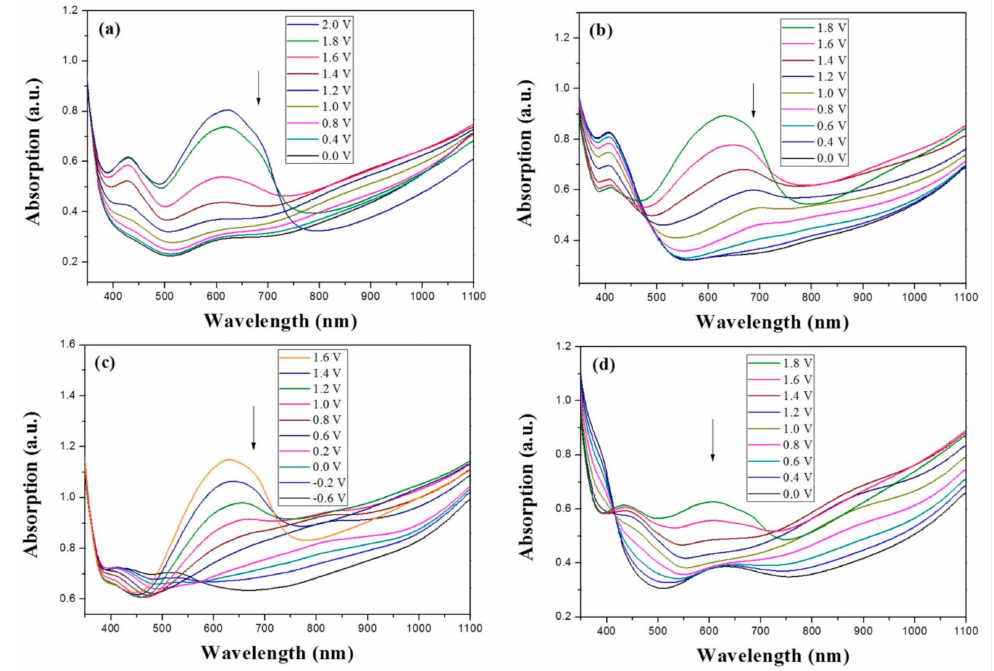
Figure 10. UV–Visible spectra of ( a ) PBPBC/PEDOT, ( b ) P(BPBC- co -BT)/PEDOT, ( c ) P(BPBC- co - CDT)/PEDOT, and ( d ) P(BPBC- co -CDTK)/PEDOT ECDs. PBPBC/PEDOT ECD did not display obvious peaks at wavelength less than 500 nm. P(BPBC- co -BT)/PEDOT, P(BPBC- co -CDT)/PEDOT, and P(BPBC- co -CDTK)/PEDOT ECDs showed peaks or shoulders at ca. 420, 510, and 380 nm at ca. 0.0 V, respectively, which were consistent with the π – π * (or n– π *) transition of P(BPBC- co -BT), P(BPBC- co -CDT), and P(BPBC- co -CDTK) in reduced states. In such situations, the PEDOT cathode was sorted as in its oxidation state and did not show distinct absorption bands in the UV–Vis region